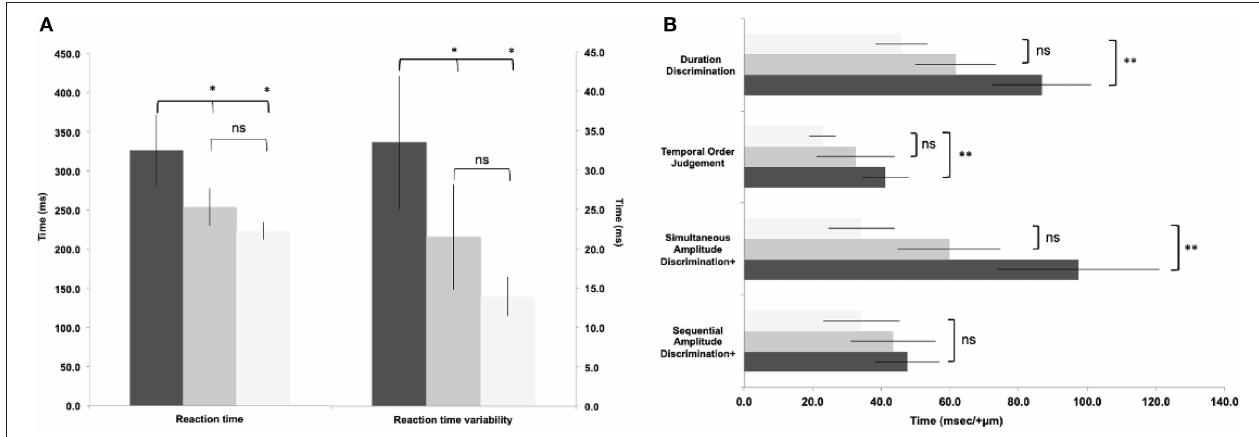
FIGURE 2 | Reaction time (a) and somatosensory data (b) between groups. Light bars represent controls, grey bars represent ’asymptomatic’ group, black bars represent ’symptomatic’ group. (Data expressed as group mean ± 95%CI; ns - not significant; * p < 0.05; ** p < 0.01.